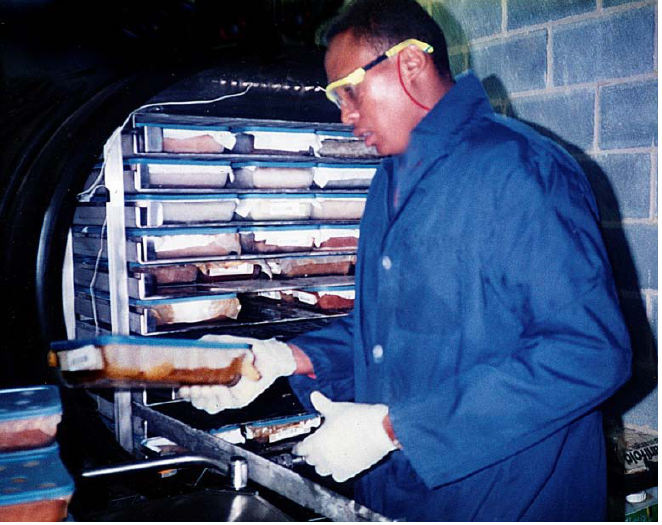
Figure 9. Pyrex dishes containing frozen plant aqueous extracts, capped with paper and a porous lid, are loaded into a VirTis SRC-250 freeze